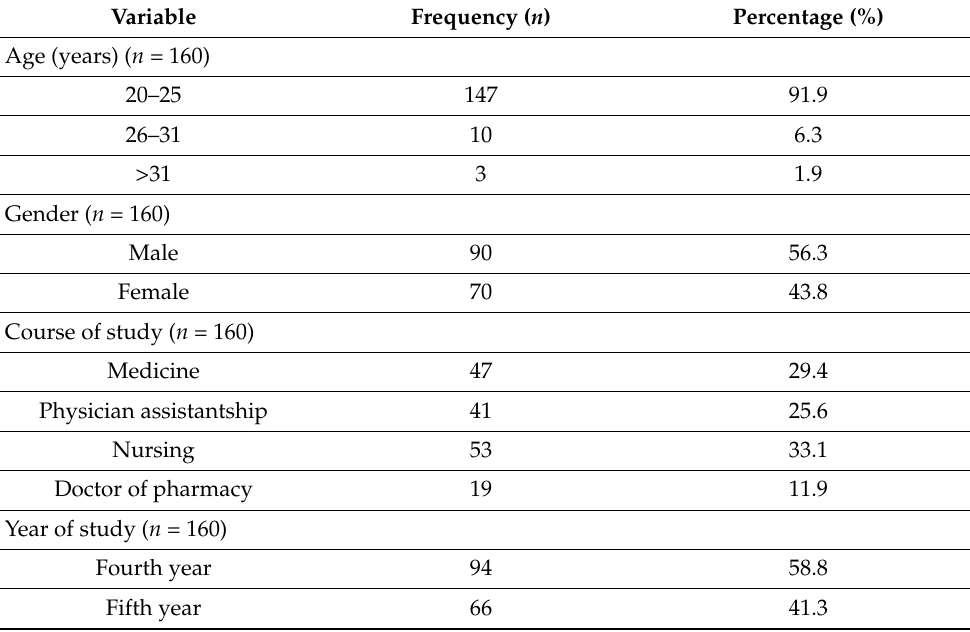
Table 1. Socio-demographic characteristics of respondents ( n =